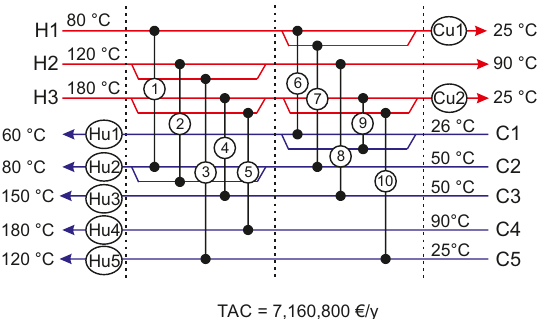
Figure 8. HEN obtained without HP and ST options case 4.